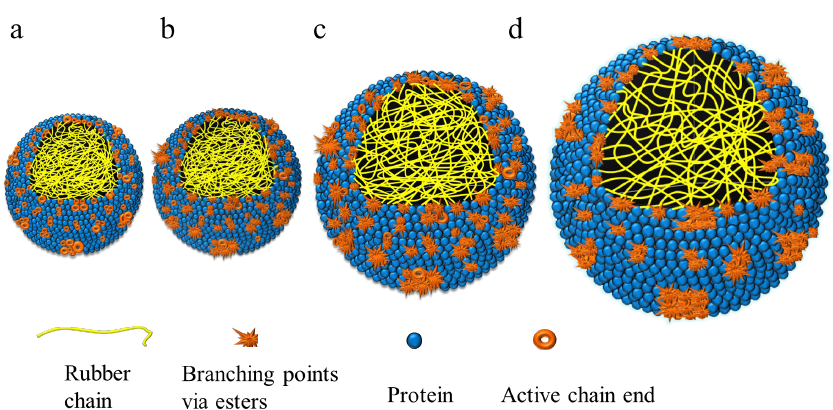
Figure 9. Presumed structure of representative rubber particles: ( a ) SRPs in IAN873 and Reyan73397; ( b ) SRPs in Dongfang93114; ( c ) rubber particles in sample 3#; ( d ) rubber particles with the most branching points.